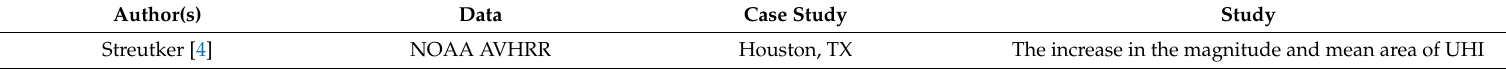
Table 1. State of the